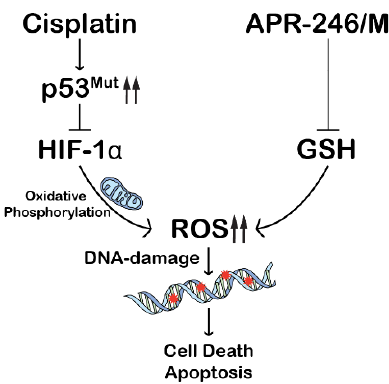
Figure 6. Underlying mechanism of the synergistic interaction between CDDP and APR-246 under hypoxic conditions. Cisplatin induces upregulation of mutant, truncated p53, which in turn degrades HIF-1α protein. HIF-1α reduction leads to a shift in metabolism, resulting in induction of reactive oxygen species (ROS). APR-246 further increases oxidative stress through inhibition of glutathione (GSH) leading to a synergistic induction of intracellular ROS, which in turn induces massive cell